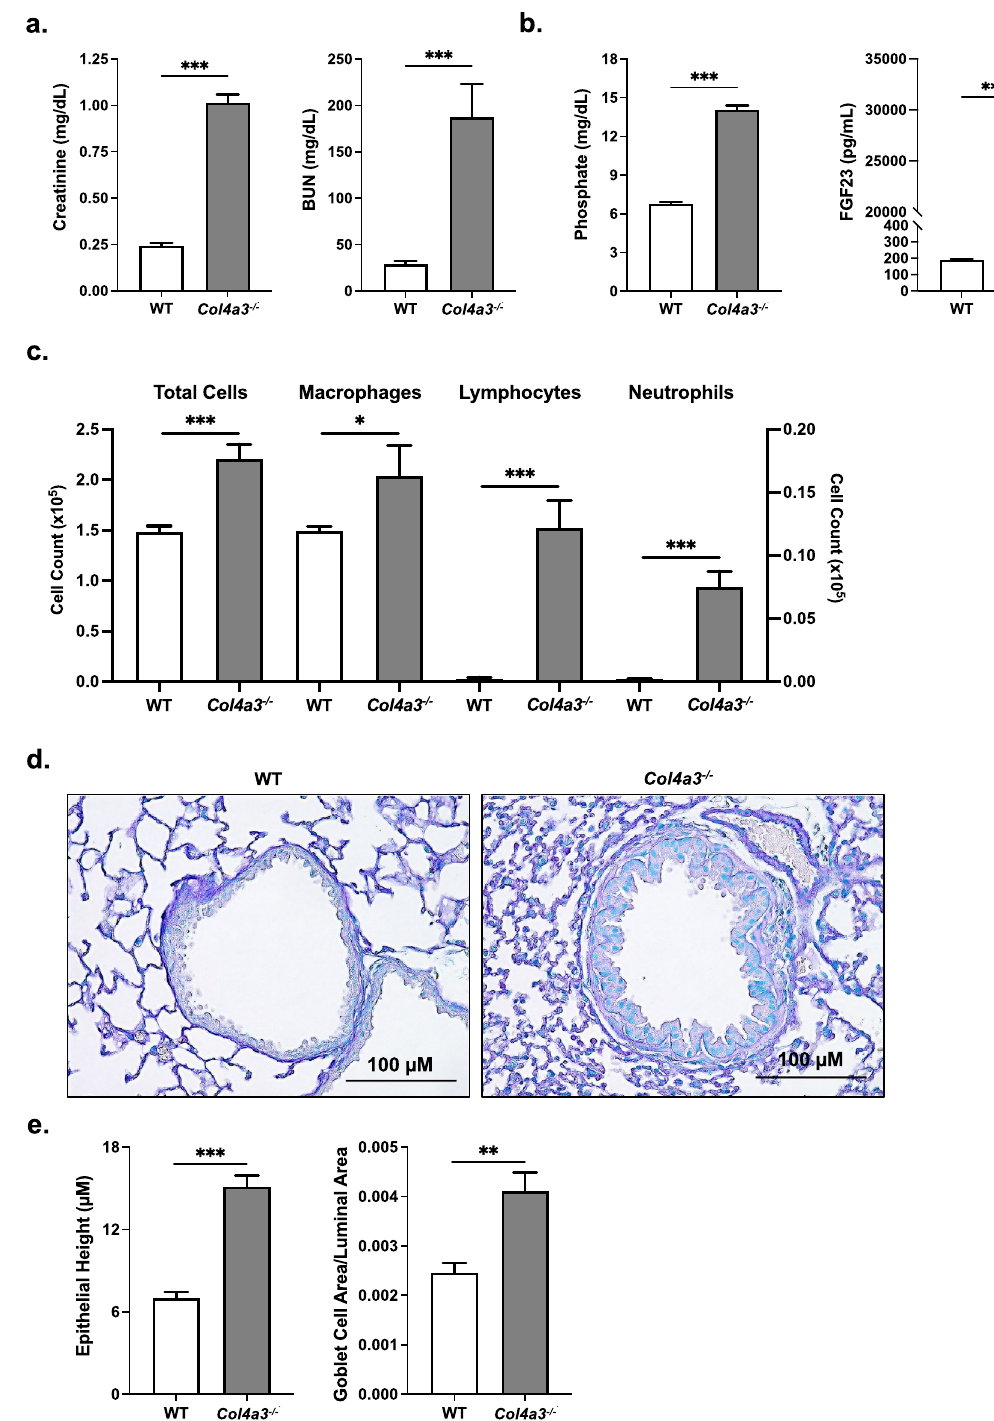
Figure 1. Col4a3 −/− mice have altered bronchiole histology and pulmonary inflammation. ( a ) Serum creatinine and BUN levels, ( b ) serum phosphate and FGF23 levels, and ( c ) total cell count and macrophage, lymphocyte, and neutrophil counts from BAL fluid of Col4a3 −/− mice and their wild type littermates. Left y-axis applies to total cell and macrophage count; right y-axis applies to lymphocyte and neutrophil count. ( d ) Representative pathology of ABPAS-stained lung sections (scale bar, 100 µM) from mouse lungs of both groups. ( e ) Height of epithelial layer and goblet cell area/luminal area quantified from ABPAS histology images; 3 regions quantified from each representative mouse lung. All values are mean ± SEM with *p ≤ 0.05, **p < 0.01, and ***p < 0.001 and n = 8 mice/group. Statistical significance was analyzed via unpaired Student’s t -test ( a – e